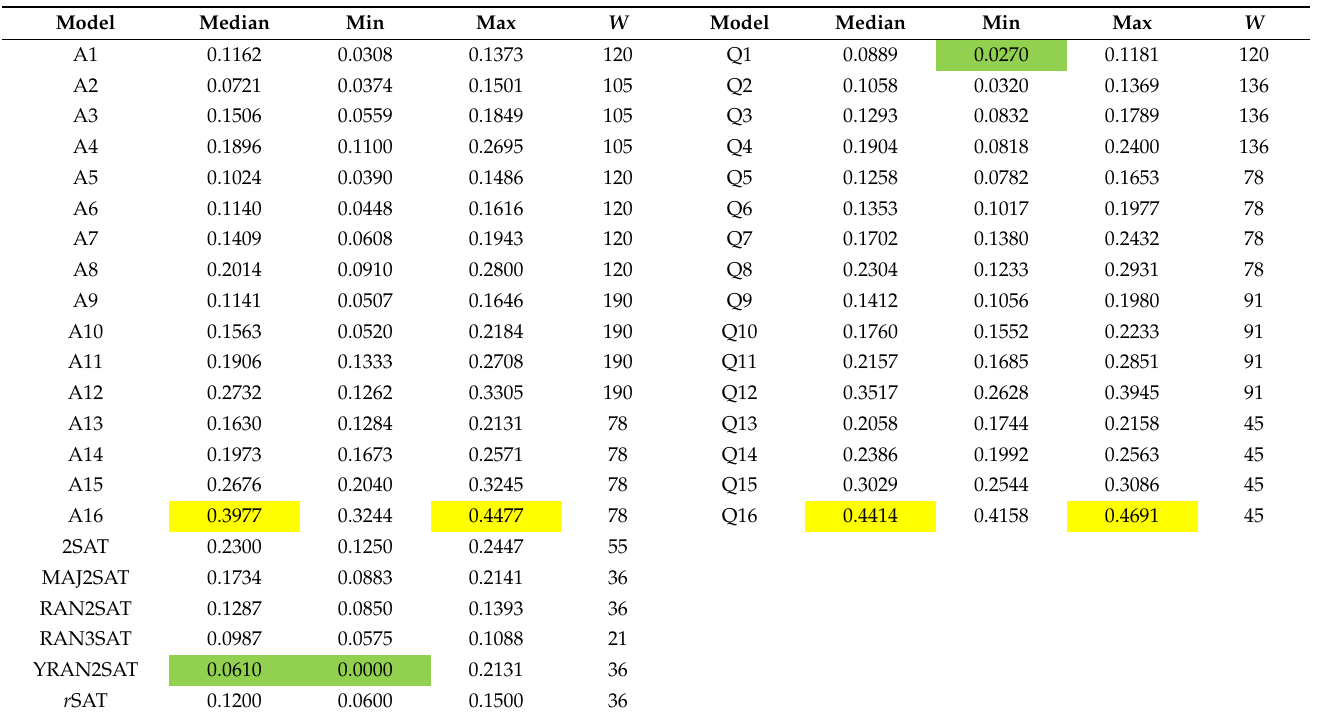
Figure 7. WFNA column representation for models in both types of logic ( a ) δ 1 2 SAT ρ , ( b ) δ 2 2 SAT ρ and recently developed logic systems. Table 11. Maximum and minimum WFNAE results for models in both types of logic δ 1 2 SAT ρ , δ 2 2 SAT ρ and recently developed logic systems with details determined by Wilcoxon test for